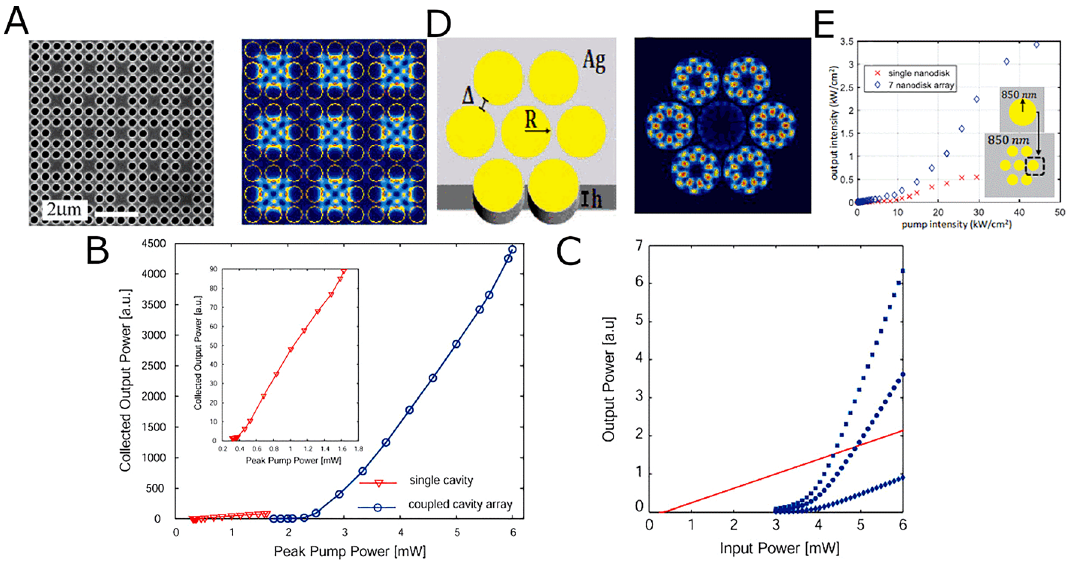
Figure 11: Higher output